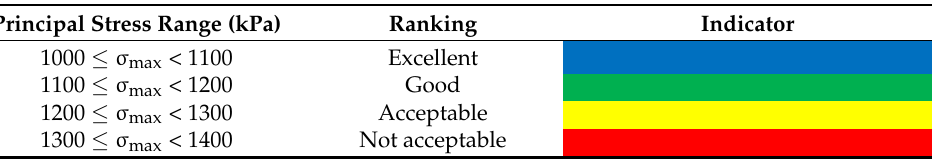
Table 7. Haditha principal stress